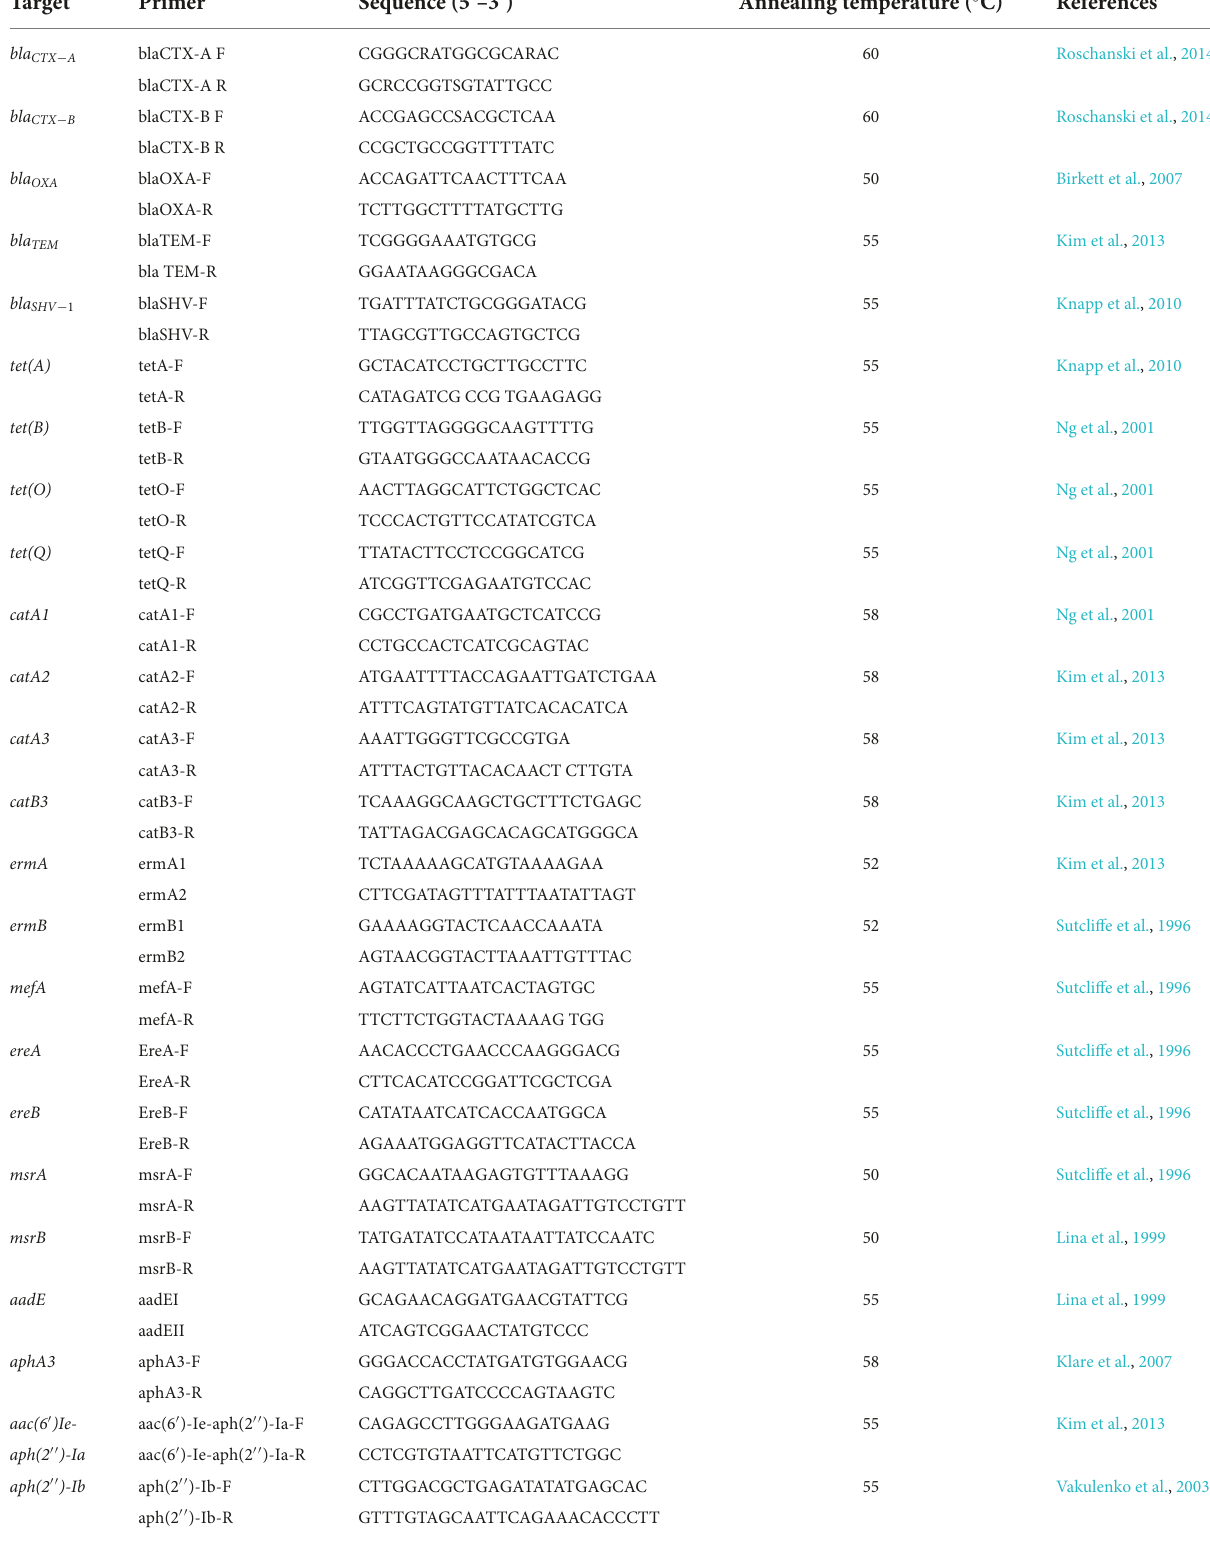
TABLE 2 Primers and conditions used in this